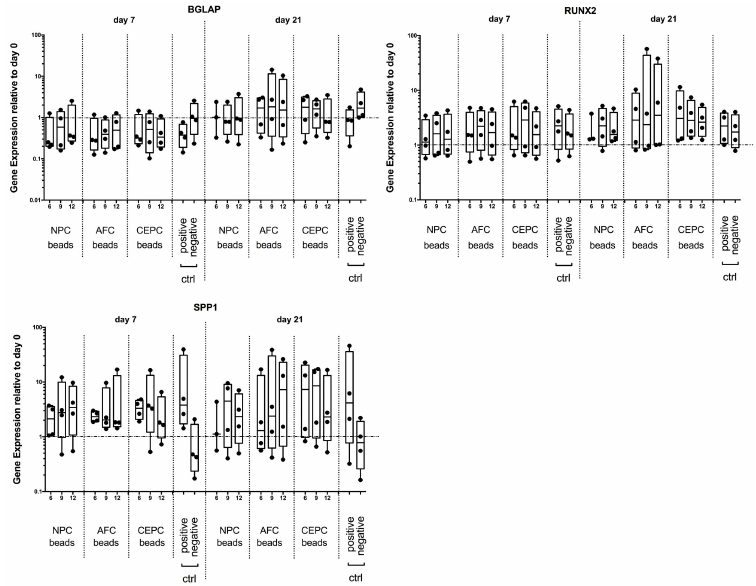
Figure 2. Relative gene expression of major bone genes of human primary osteoblasts (OB) co-cultured with 6, 9 or 12 alginate beads each containing ~80,000 human primary nucleus pulposus cells (NPC), annulus fibrosus cells (AFC), cartilaginous endplate cells (CEPC) or 6 empty beads (positive controls) and negative control. All experimental groups were stimulated with osteogenic medium except negative control, where OB were cultured with basal medium. Gene expression was measured at days 7 and 21. Data are presented as min to max with median and all data points, N =